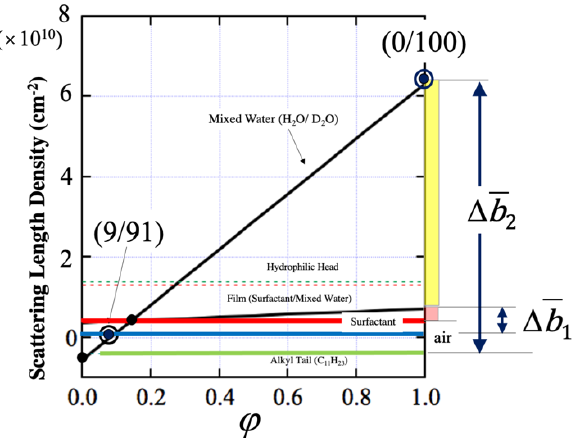
Figure 6. Coherent scattering length density (SLD) as a function of the volume fraction of D 2 O ( ϕ ). The SLD for mixed water (H 2 O/D 2 O) is shown by a thick black line. The SLD for a hydrophilic head of C 12 –EtOH– β Ala and C 12 –Me– β Ala surfactant is 1.319–1.393 × 10 10 cm − 2 (broken thin lines), whereas an alkyl tail (C 11 H 23 ) is − 0.399 × 10 10 cm − 2 (thick green line). Averaging the head and tail groups, the SLD values for SDS, C 12 –EtOH– β Ala, and C 12 –Me– β Ala are b = 0.31, 0.42, and 0.36 × 10 10 cm − 2 , respectively (red line). The SLD of (H 2 O/D 2 O) (91/9 vol/vol) is zero, i.e., a matching point in the scattering length between air and mixed water. The SLD for a foam film is indicated by a thick black line by considering the volume fractions of the surfactant ( ψ s , indicated by the yellow bar) and water ((1 − ψ s ), indicated by the pink bar). The scattering contrast between the whole film and air is indicated by arrow ∆ b 1 . The scattering contrast of a micelle in a film (alkyl tail and mixed water) is indicated by arrow ∆ b 2 . Note that the SLD for air (blue line) is